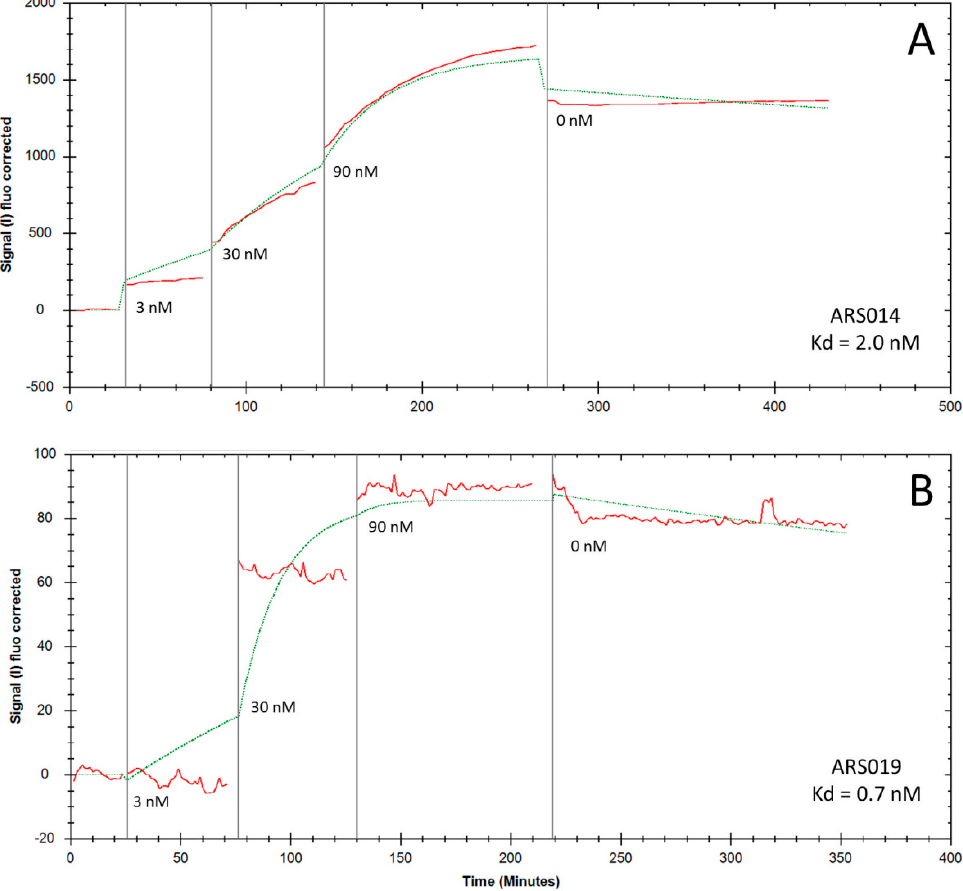
Figure 6. Binding of ARS014 (panel ( A )) and ARS019 (panel ( B )) to HaCaT cells tested by LigandTracer Green Line system. For binding assay, 10 6 cells were plated overnight on Petri dish and the next day, in vivo biotinylated His 6 -ARS-TolA-AVI proteins were added into medium and incubated gradually at three different concentrations. Cell-bound proteins were stained with streptavidin-APC conjugate and the measured binding curve (red line) was analyzed using the TraceDrawer software (fitted curve, green line). Analysis of the binding affinities and rate-off kinetics indicated K d values for ARS014 and ARS019 to be 2 nM and 0.7 nM, respectively.